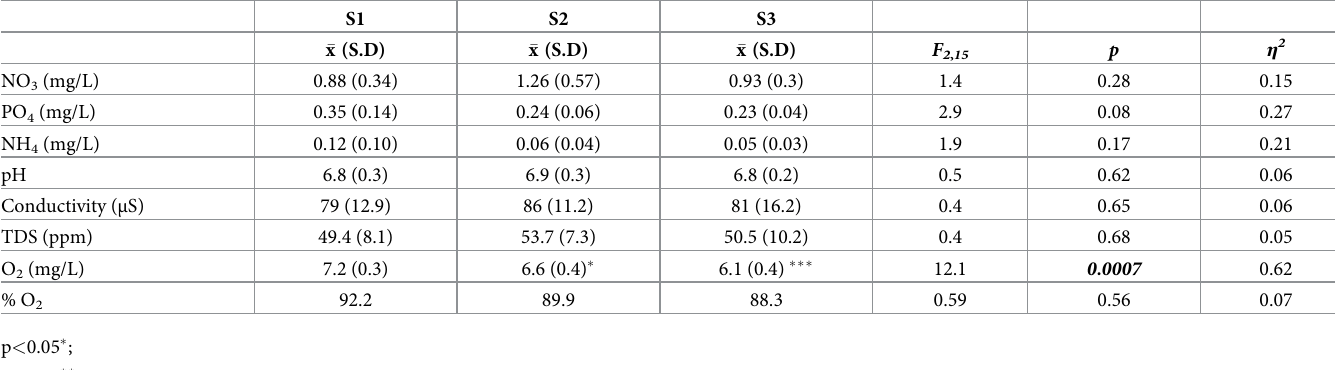
Table 1. One-way ANOVA estimates (mean � x ), standard deviation (SD), and F value s of physical and chemical parameters analyzed in water from chambers of the mesocosm at three temperature scenarios: S1 (control), S2 (+2.5˚C), and S3 (+5˚C). p value (95%). η 2 generalized effect size (eta-squared). S1